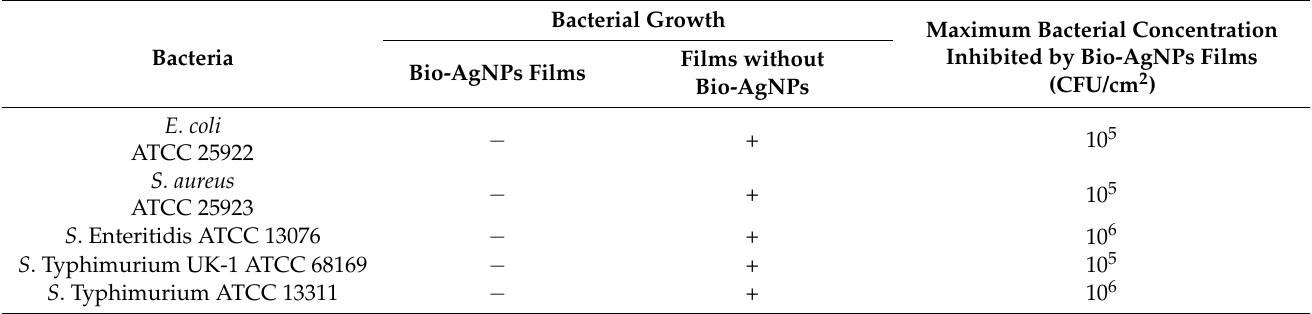
Table 2. Maximum concentration of bacteria (CFU/cm 2 ) inhibited by bio-AgNP films.